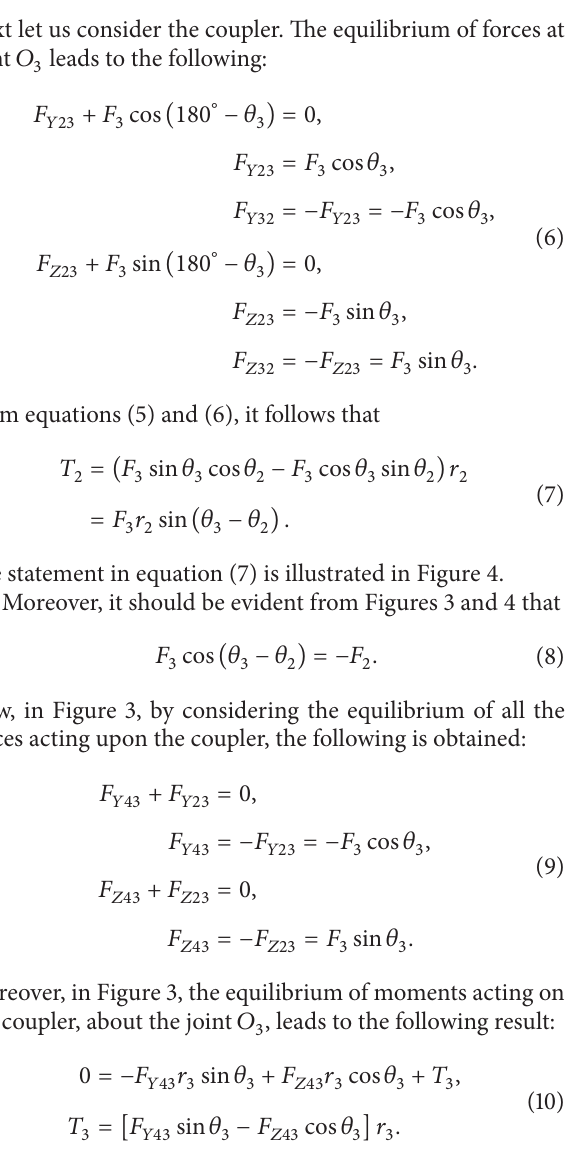
Table 1: Data for a PE 400 by 600 single toggle jaw crusher (mm). 𝑟 𝜃 1 sin 1 45.3 815.7 12 1085